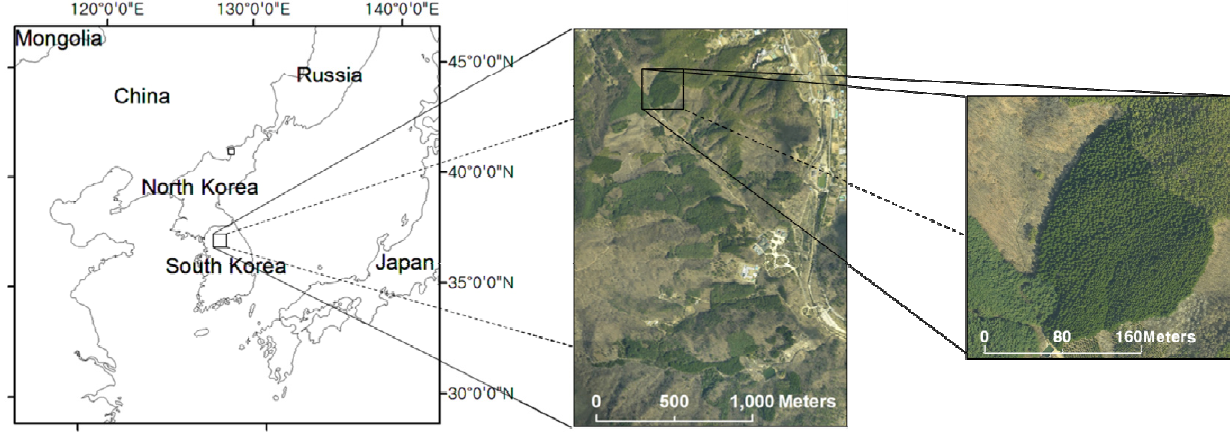
Figure 1. Digital aerial photograph of the study area acquired on 3 April